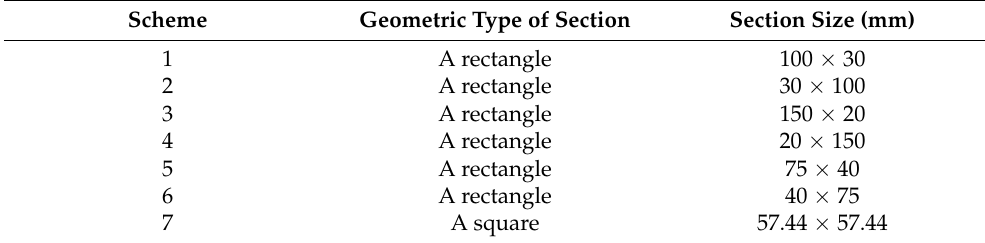
Table 7. Geometric size simulation scheme of the phase change heat storage